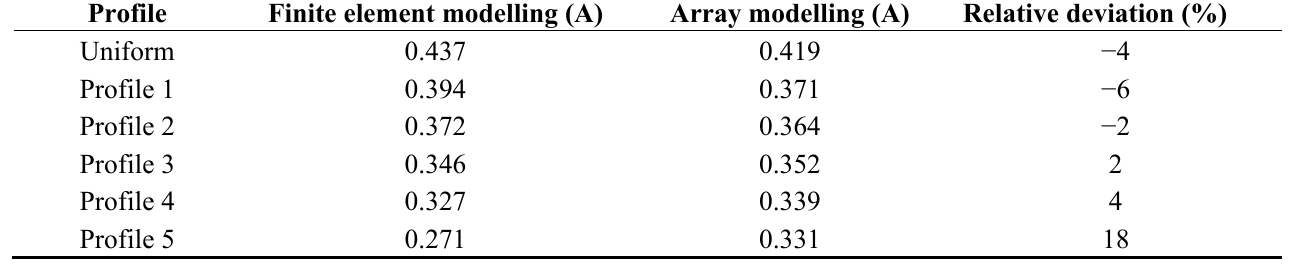
Table 7. Simulation results of short-circuit current in two modelling approaches.